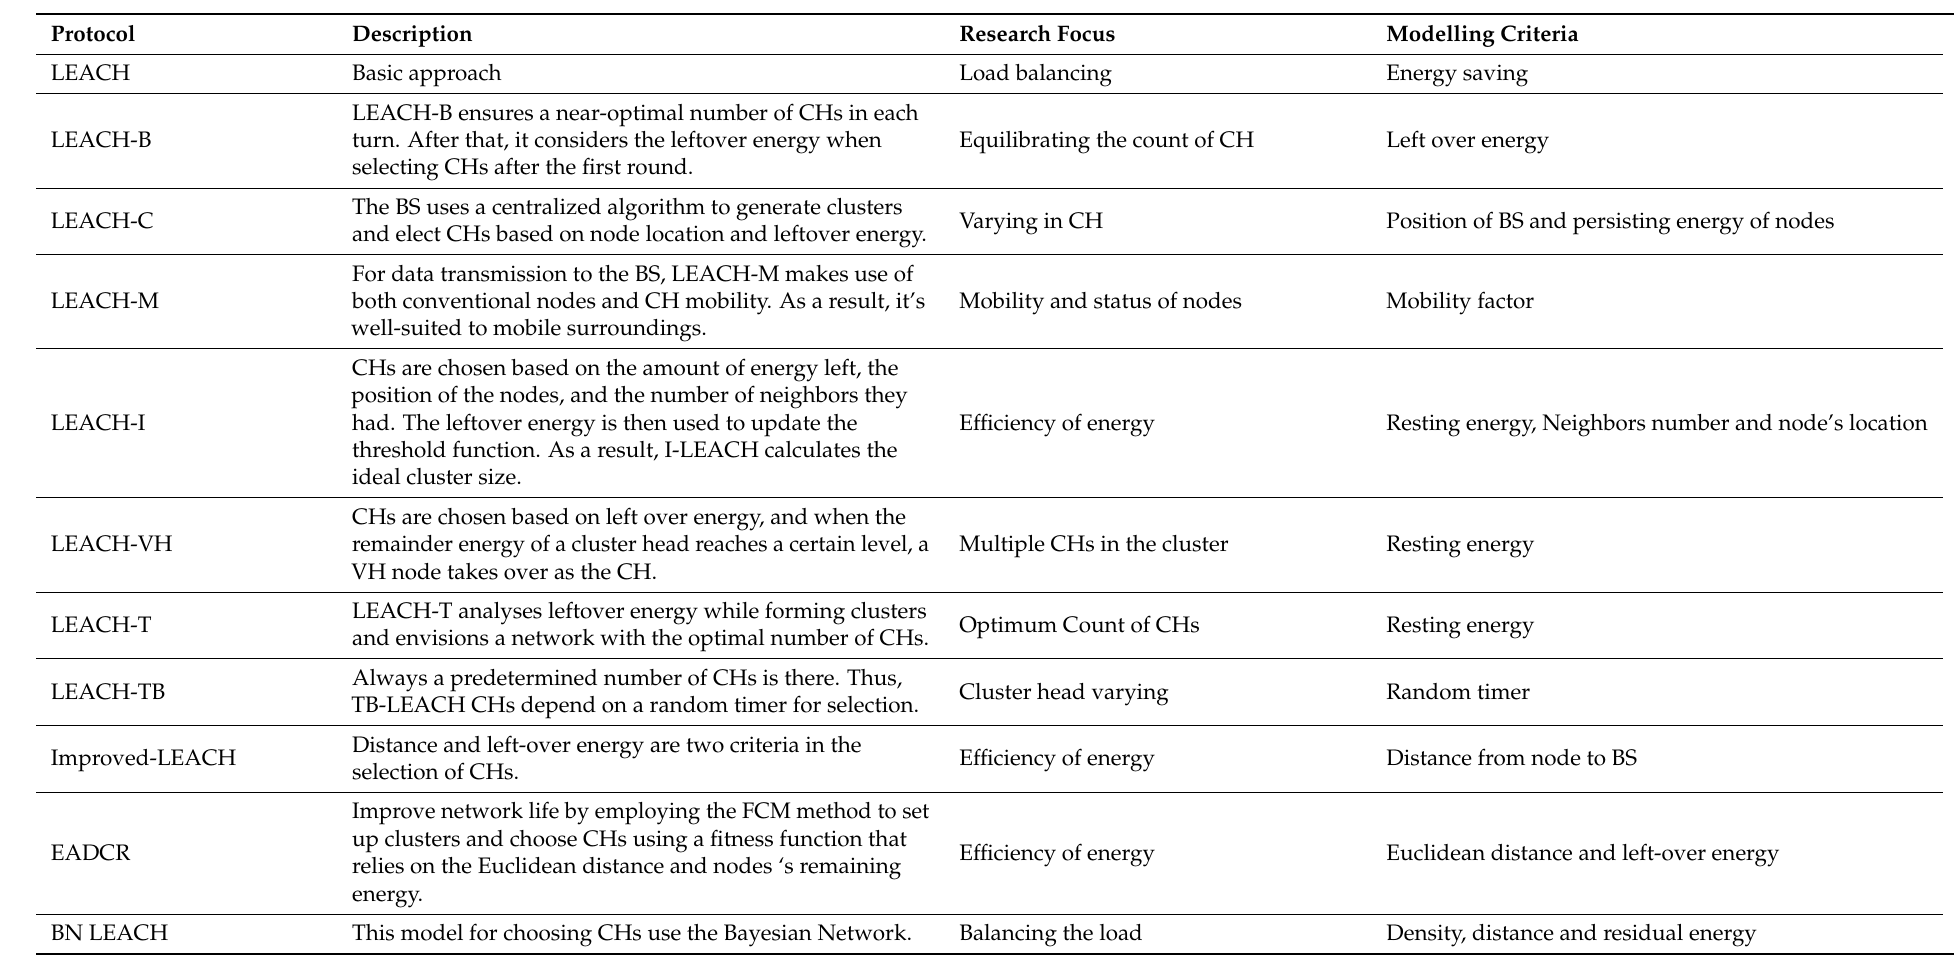
Table 1. Comparison of LEACH